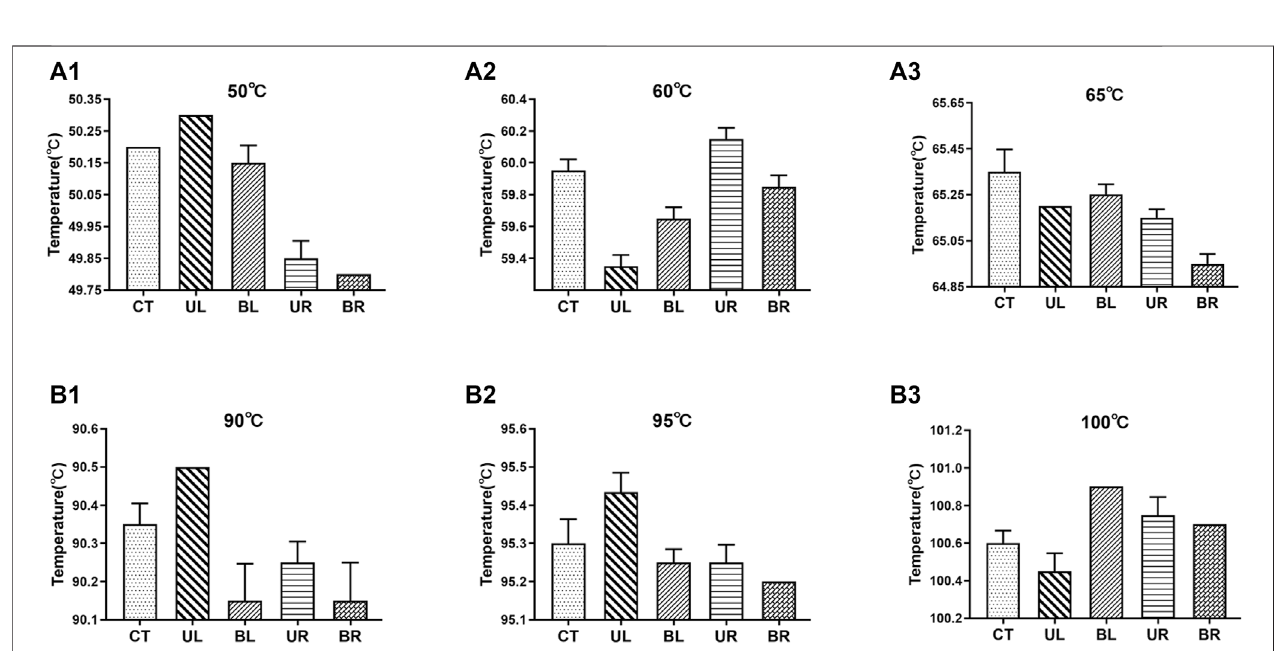
FIGURE 2 | Temperature values at the fi ve measurement points of dual temperature modules. CT, center; UL, upper left; BL, bottom left; UR, upper right; BR, bottom right. (A1 – A3) the target temperature was set to 50 ° C, 60 ° C, and 65 ° C, respectively; (B1 – B3) the target temperature was set to 90 ° C, 95 ° C, and 100 ° C, respectively. Values represent the mean ± SD of six measurements of the temperature at each